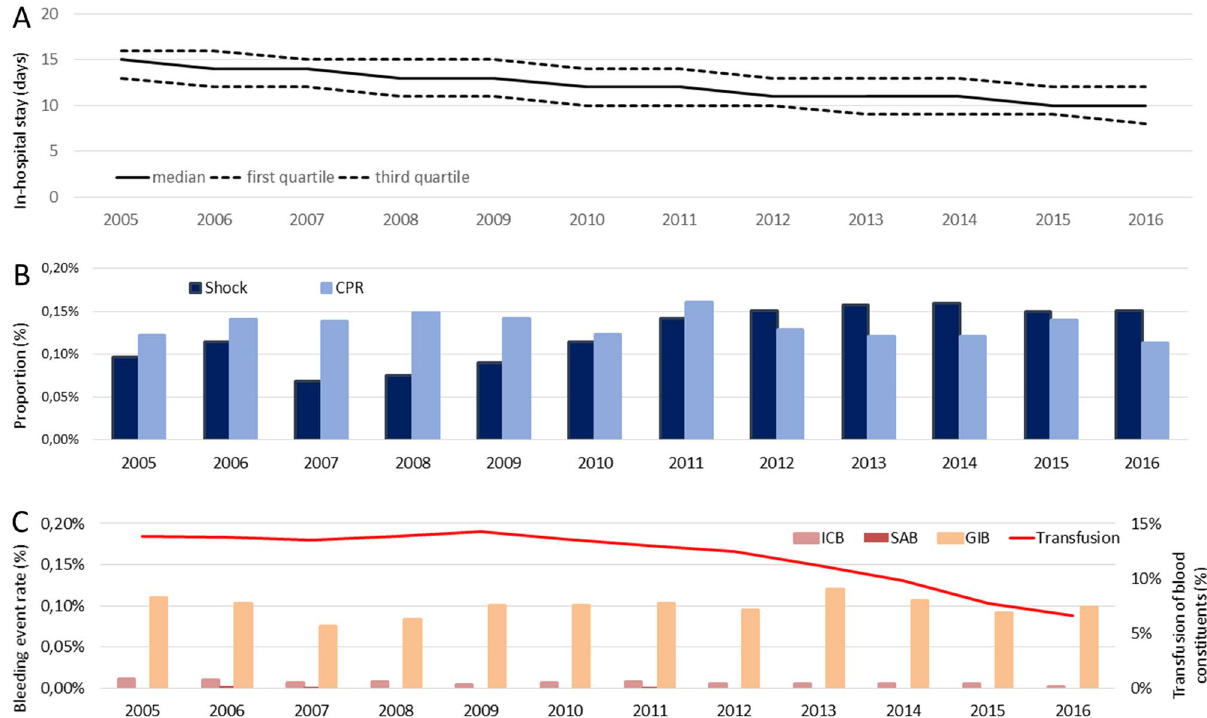
Figure 2. Time trends in length of hospitalization and rates of serious complications in patients undergoing elective primary KJR in Germany from 2005 to 2016. ( A ) Median duration of hospitalization (solid black line) with 25% and 75% IQR (dashed black lines). ( B ) Percentage of patients developing shock (dark blue bars) and undergoing cardio-pulmonary resuscitation (CPR, light blue bars) out of all patients undergoing elective KJR. ( C ) Percentage of patients with bleeding events such as intracerebral bleeding (ICB, light red bars), subarachnoid bleeding (SAB, dark red bars) and gastrointestinal bleeding (GIB, orange bars) as well